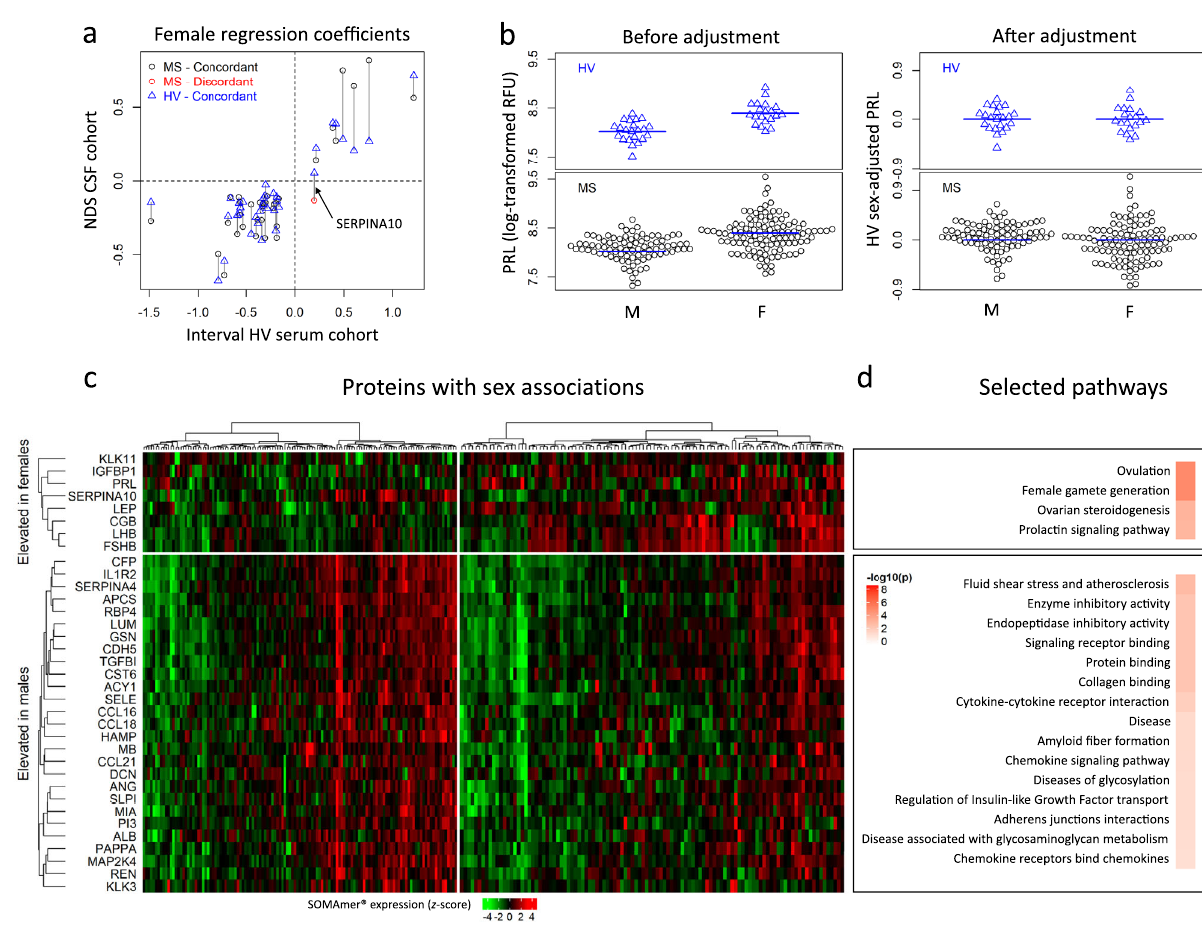
Fig. 3 | Adjusting SOMAmers to subtract effects of physiological sex associa- tions. a Regression coef fi cients for the 35 SOMAmers with sex associations from cerebrospinal fl uid (CSF) and serum. Blue triangles compare effect sizes (regression coef fi cients) of protein association with sex measured in healthy volunteer (HV) serum in the published (INTERVAL) study ( x -axis) with internalHV CSFcohort( y -axis).Circlescorrespondtomultiplesclerosis(MS)CSFcoef fi cients with concordant (black) and discordant (red) associations with sex compared to HV. Vertical lines connect the CSF coef fi cients for our MS and HV cohorts for the same biomarker. SERPINA10, identi fi ed by a black arrow, showed discordant association with sex in MS versus HV. b Example of adjusting CSF protein con- centration to subtract effects of physiological sex differences on prolactin (PRL).